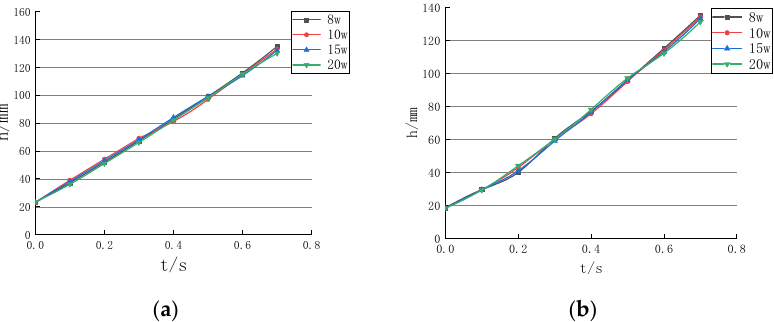
Figure 4. The change curve of bubble position with time under different grid numbers: ( a ) Top ( b ) Bottom.